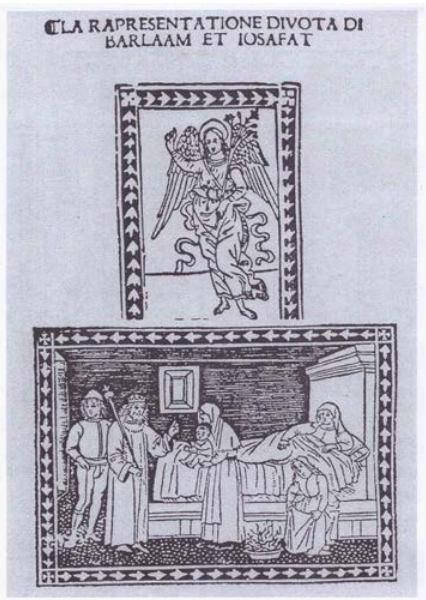
Figure 16 – Bernardo Pulci, La Rapresentatione divota di Barlaam et Iosafat , s.n.t. [but Firenze, Miscomini, around 1495], f. a1r (BNCF, Banco Rari 189.e). By permission of Ministero per i beni e le attività culturali / Biblioteca Nazionale Centrale. Firenze